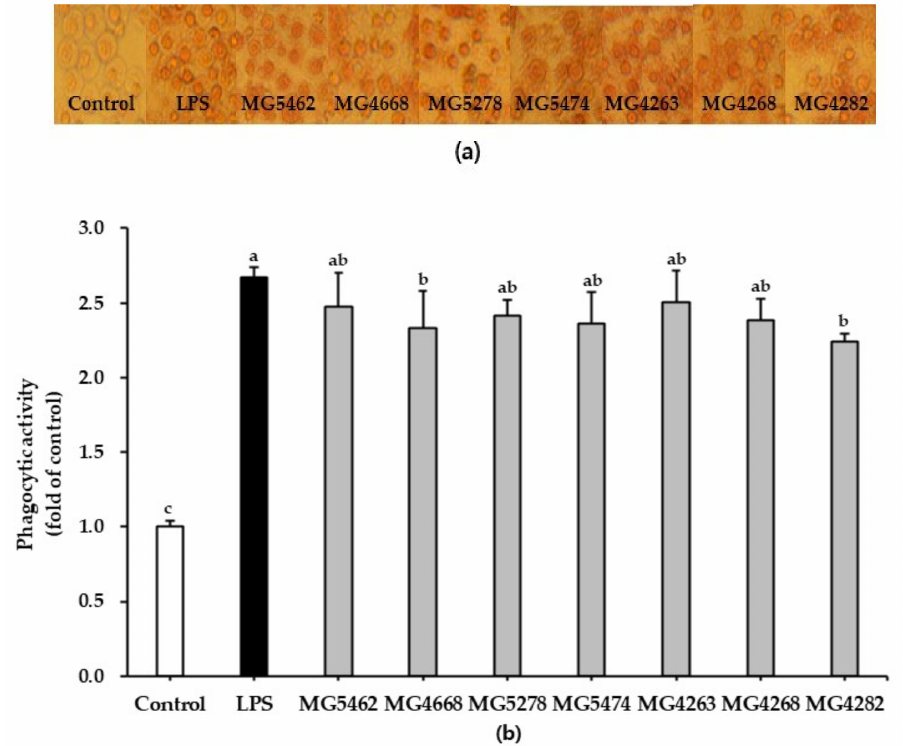
Figure 1. Effect of CFS from LAB strains on the phagocytosis of RAW264.7 macrophage cells. Cells were treated with LPS (10 ng/mL) or CFS (5 mg/mL) for 24 h, and phagocytosis was evaluated